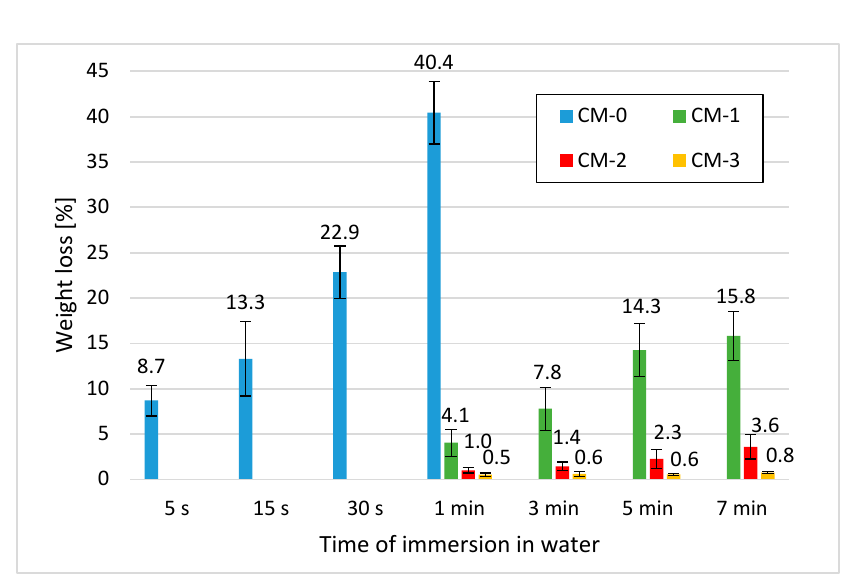
Figure 5. Glauconite clay mortar samples after 1 min of the water immersion. From the left: CM-1, CM-2, CM-3, CM-0. 3.3. Shrinkage and the Weight Loss on Drying The average values of the length loss of the samples as a result of shrinkage and the standard deviation are shown in Table 4, and for better visualization of the results, the trends of the length loss over time are shown in Figure 6. Table 4. The average values of the length loss of the samples as a result of shrinkage and the standard deviation. Mortar